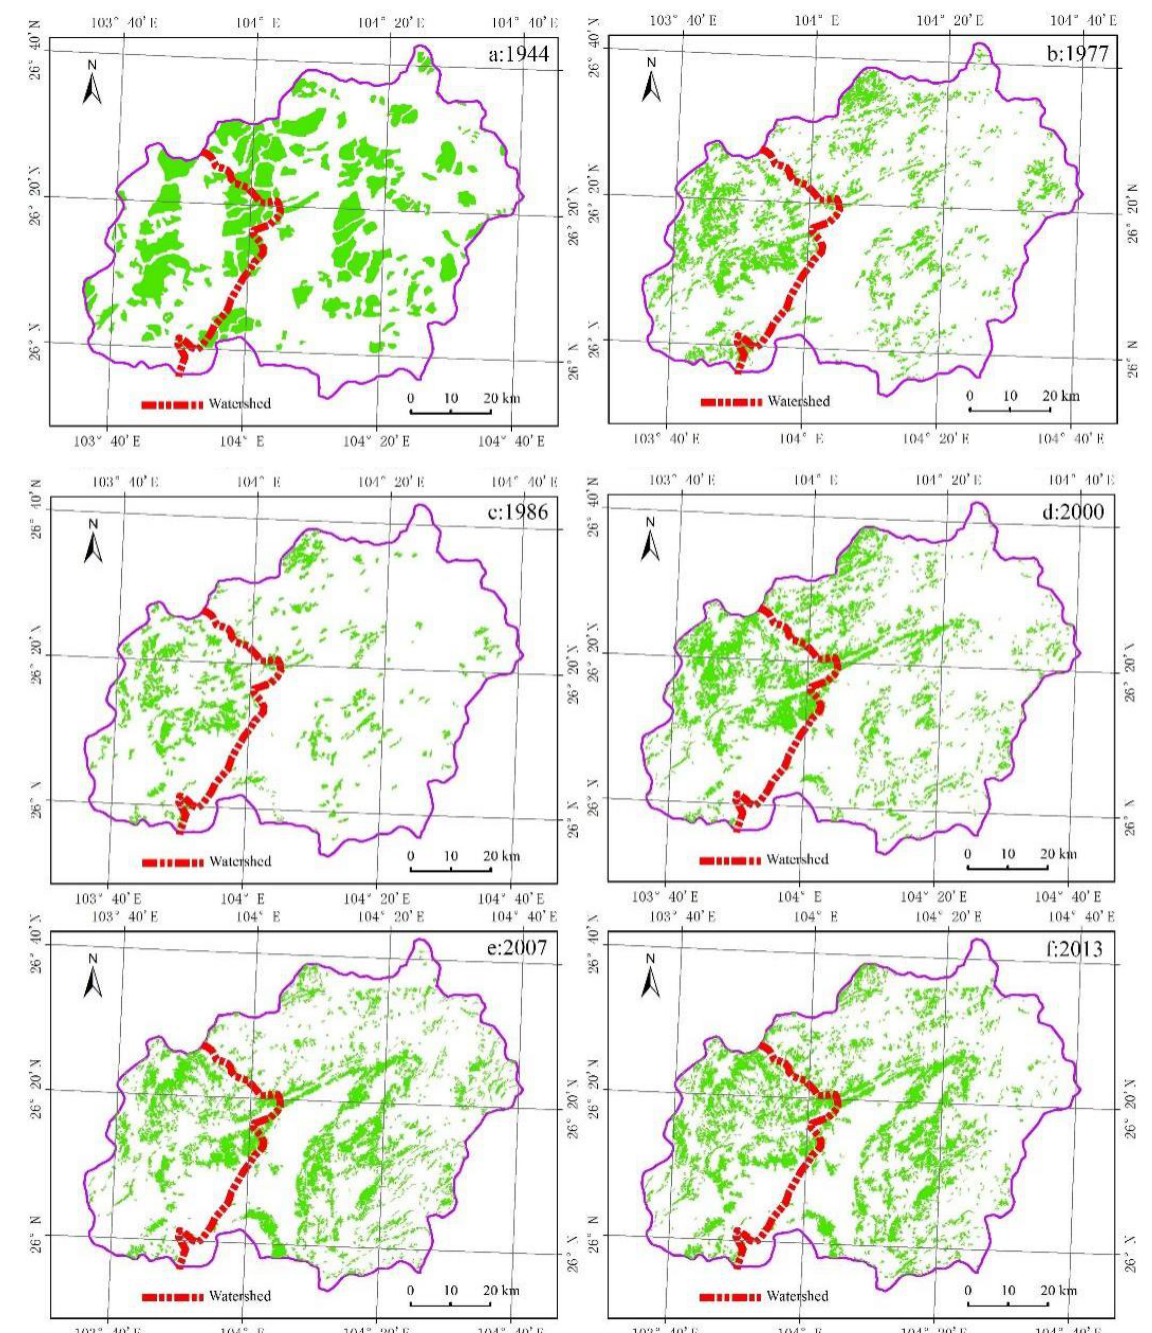
Figure 4. The spatial distribution information maps of forest landscape in the different historical times. (We constructed this map using ArcGIS9.3 (http://www.esri.com/arcgis/about-arcgis) (accessed on 25 December